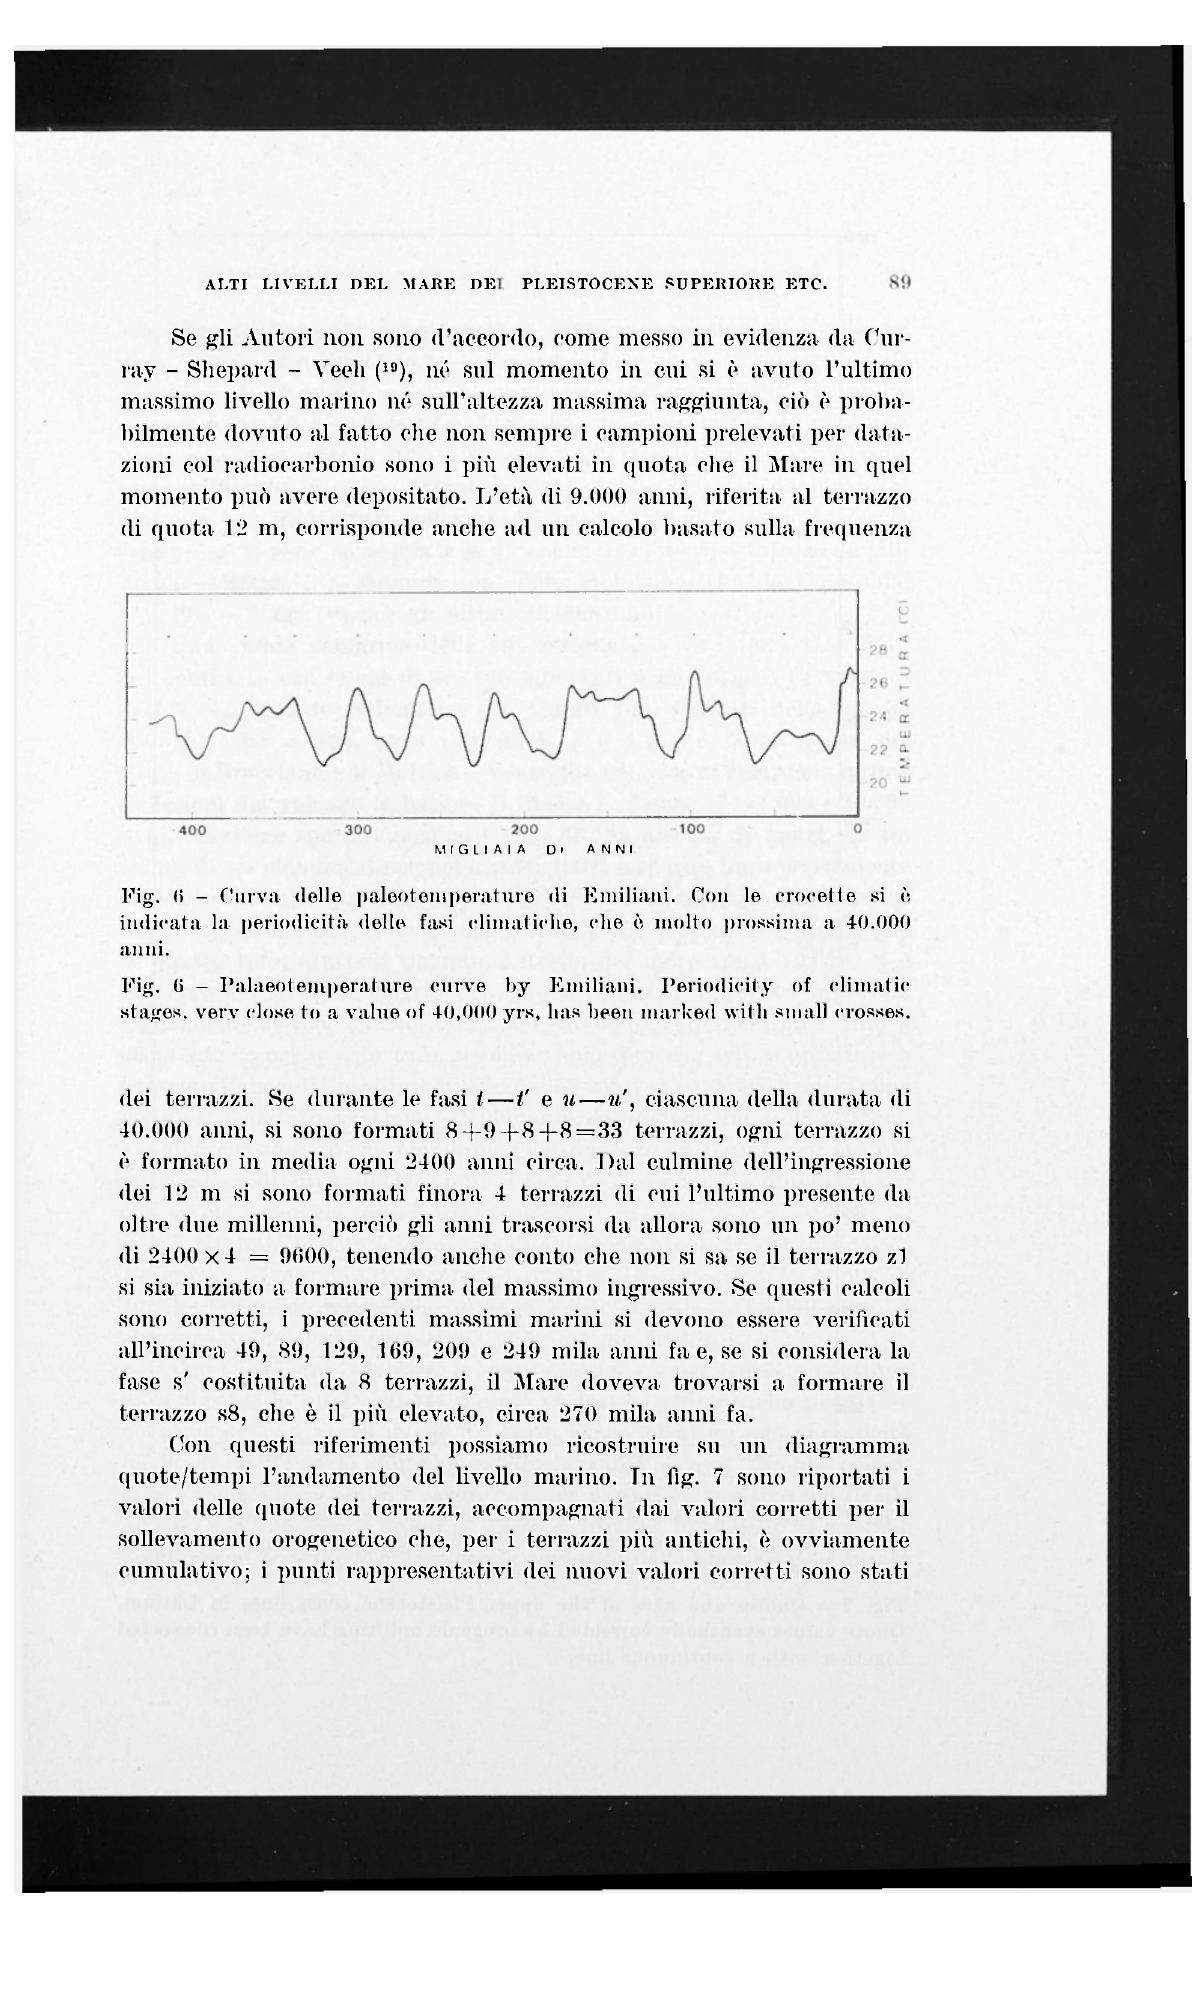
Fig. 6 - Curva delle paleoteniperature di Emiliani. Con le crocette si è indicata la periodicità delle fasi climatiche, che è molto prossima a 40.000 anni. Fig. 6 - Palaeotemperature curve by Emiliani. Periodicity of climatic stages, verv dose to a vaine of 40,000 yrs, lias been marked with Binali crosses.